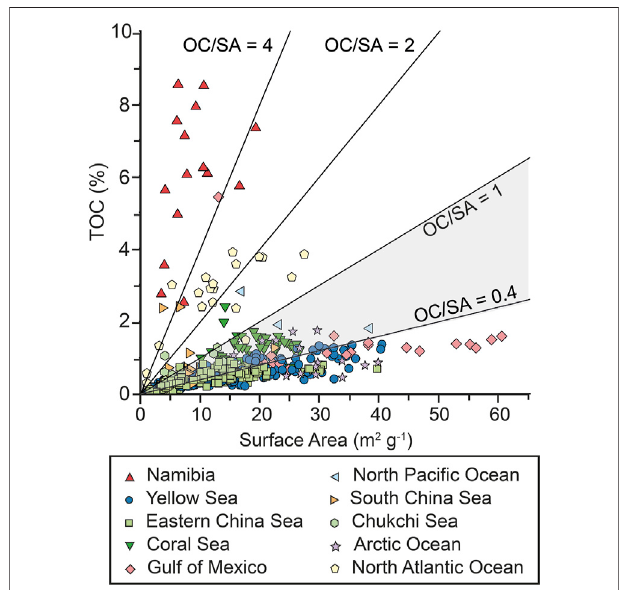
FIGURE 5 | Comparison of typical OC/SA of marine stations with Namibian shelf samples (this study). The high values of OC (wt%) make the Namibian shelf a prime location for studies on the effects of OC accumulation (Van Der Voort et al., 2021; primary references in Supplementary File S4